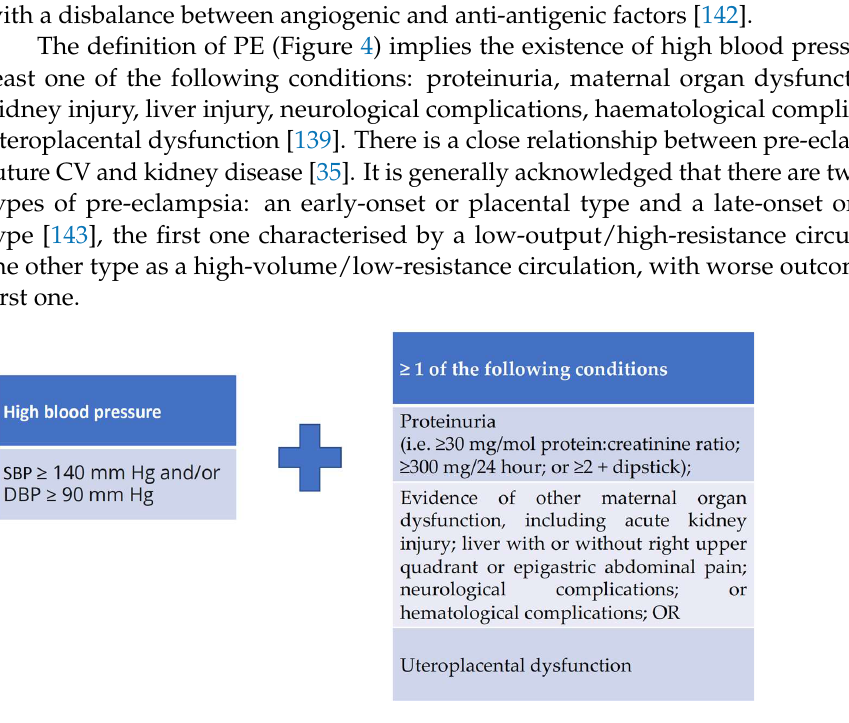
Figure 4. Diagnosis criteria for pre-eclampsia. SBP = systolic blood pressure, DBP = diastolic blood pressure.